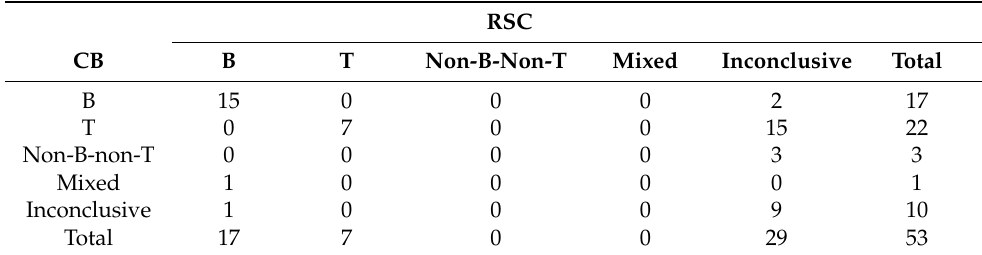
Figure 1. B-cell lymphoma, dog. ( A ) Fine-needle aspiration smear of an enlarged lymph node. The predominance of medium to large-sized lymphocytes with a round to slightly indented nuclei and prominent nucleoli. Hemacolor; bar = 28 µ m. ( B ) Immunolabeling on Romanowsky-stained cytology slides (i.e., applied to a previously stained cytology smear). More than 80% of the neoplastic lymphocytes showed positive nuclear reactivity for PAX5, with few residual lymphocytes positive for CD3 (inset). Diaminobenzidine chromogen, Hematoxylin counterstain; bar = 28 µ m (58 µ m for the inset). ( C ) Immunolabeling on matched cell tube block sections. A similar percentage of positive lymphocytes for PAX5 and CD3 (inset). Diaminobenzidine chromogen, Hematoxylin counterstain; bar = 38 µ m (68 µ m for the inset). Table 6. Matrix comparing the immunophenotype defined by a board-certified pathologist in im- munolabeling on previous Romanowsky-stained cytology (RSC) slides and on the matched cell blocks